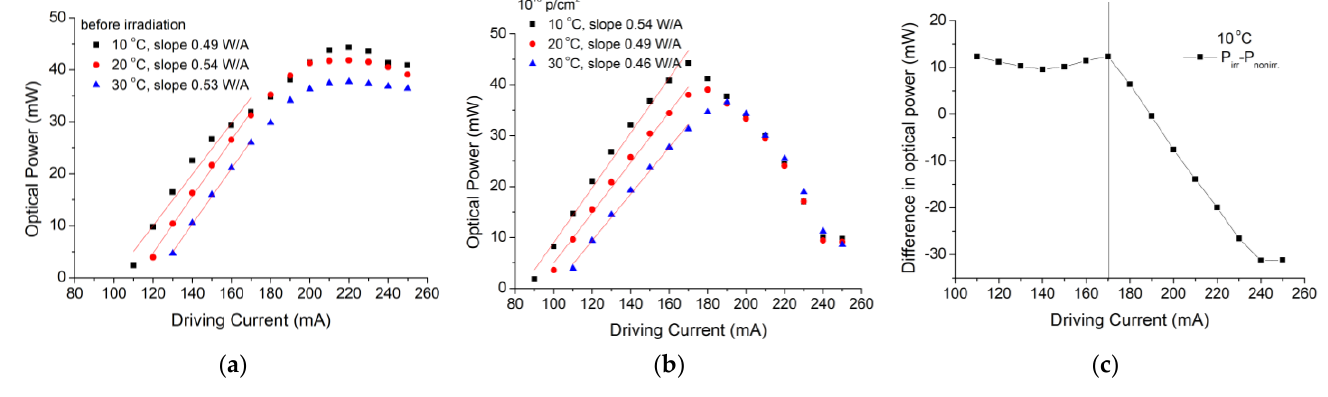
Figure 3. The emitted optical power vs. the driving current for three case temperatures ( a ) before irradiation and ( b ) after 10 16 p/cm 2 irradiation; ( c ) difference between the optical power before and after irradiation corresponding to the device cooled at 10 °C.